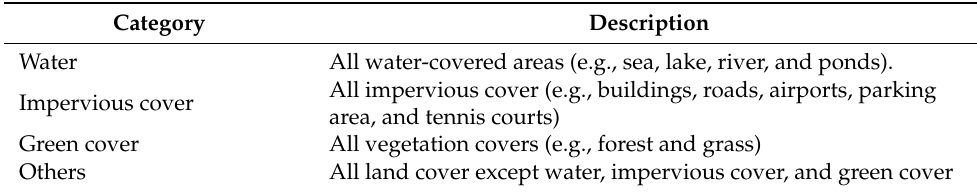
Table 2. Description of land-use–land-cover (LULC) categories considered for the classification of study area. Category Description Water All water-covered areas (e.g., sea, lake, river, and ponds). All impervious cover (e.g., buildings, roads, airports, parking Impervious cover area, and tennis courts) Green cover All vegetation covers (e.g., forest and grass)